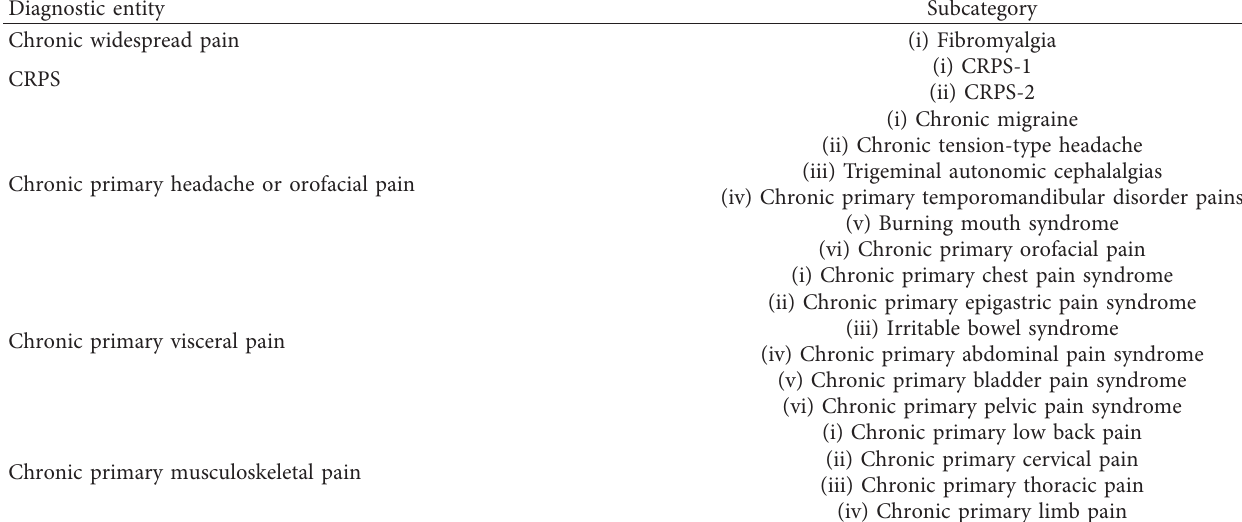
Table 1: Classification of chronic primary pain [4,